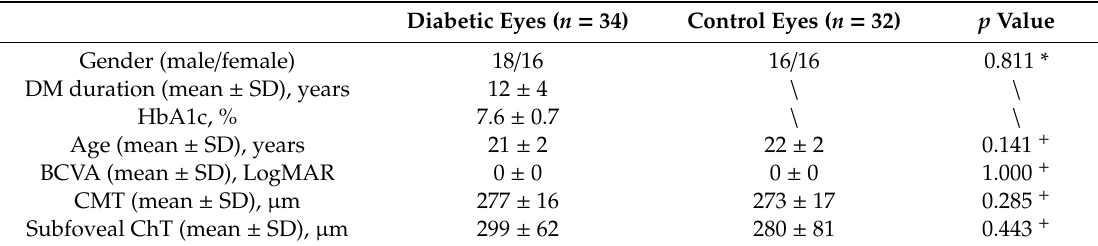
Table 1. Demographic and clinical characteristics of study population.